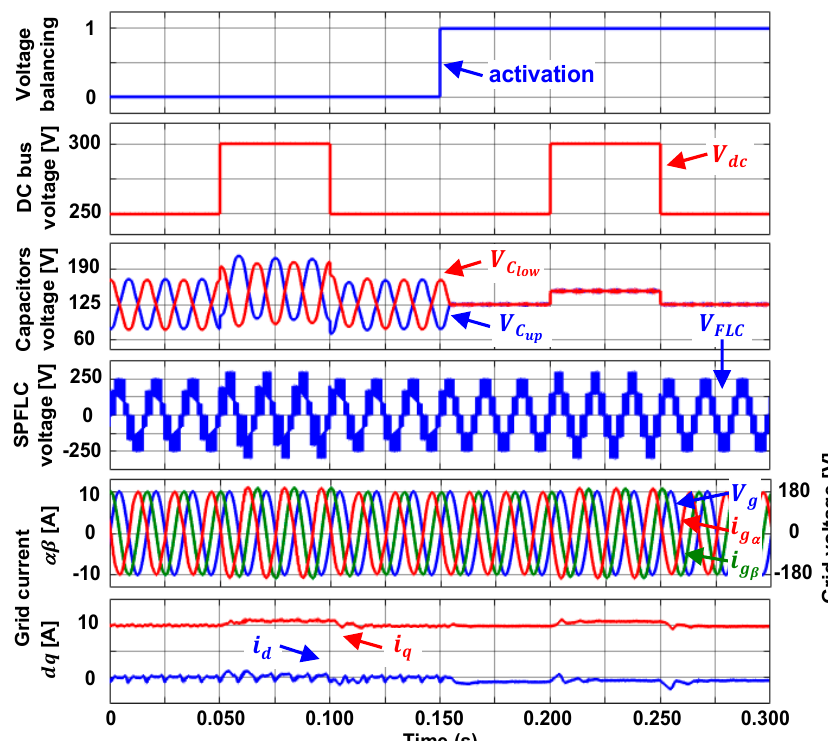
Figure 9. Performance of the voltage balancing strategy and the vector control for the proposed grid-tied SPFLC during a DC bus voltage